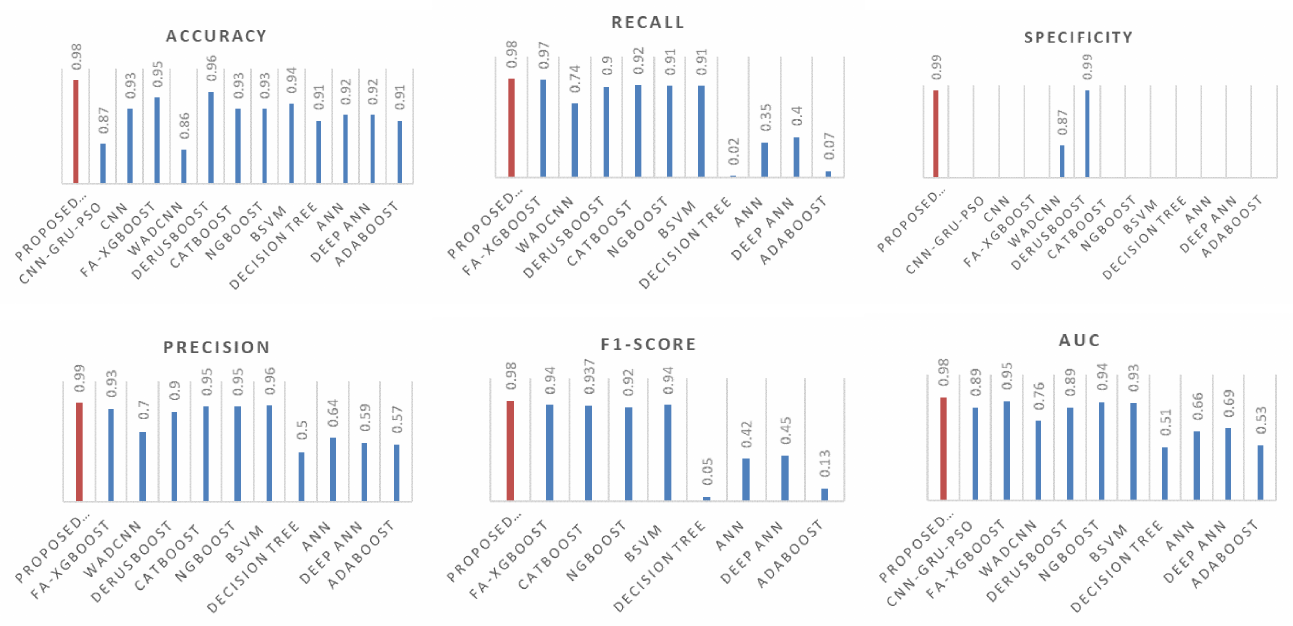
Figure 8. Results comparison of other methods with the proposed